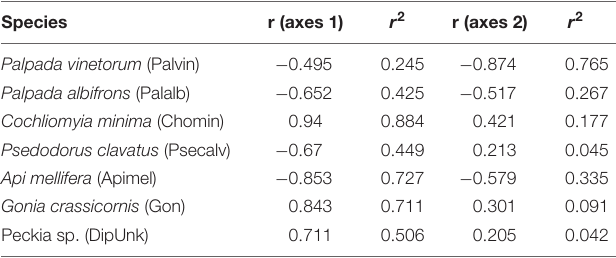
TABLE 1 | Kendall correlation coefficients (r) with ordination axes resulting from Non-metric Multidimensional Scaling (NMDS) analyses for seven species of the communities on four mango fields each containing a different cultivar (Julie, Keitt, Kent, Tommy Atkins). Species r (axes 1) r 2 r (axes 2) r